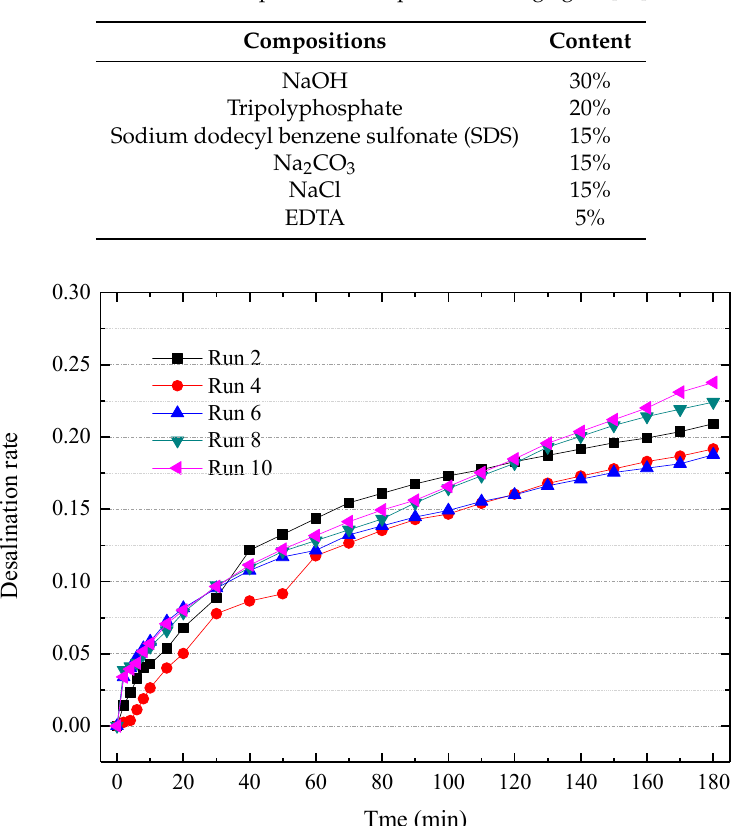
Table 3. The composition of a special cleaning agent [50].